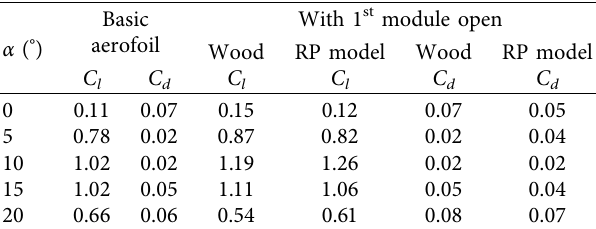
Figure 22: Wind tunnel testing of 3d printed airfoil. Table 5: Table 4 C l and C d values of wood-based model and RP model.